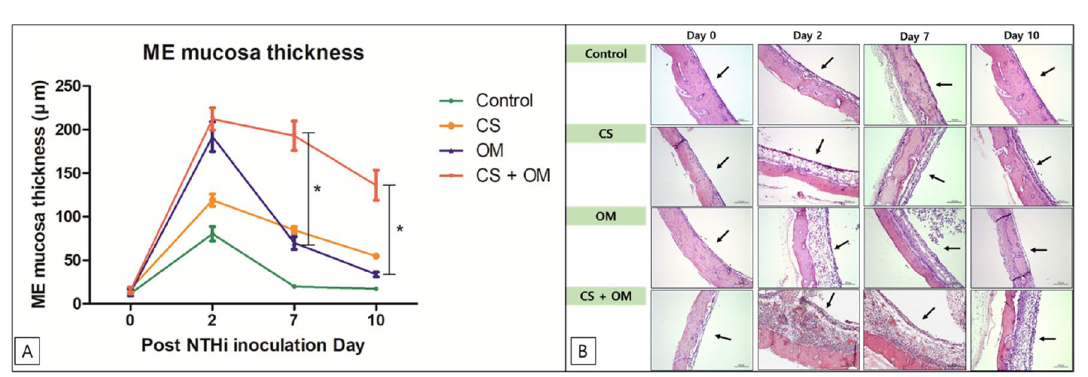
Figure 2. ( A ) Measurement of the middle ear (ME) mucosal thickness. ( B ) The ME mucosa is stained using hematoxylin and eosin (× 200